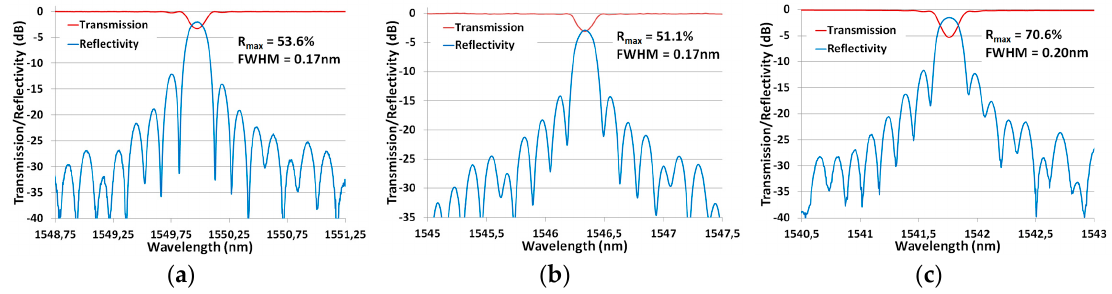
Figure 6. Transmission/reflectivity spectra of FBG written in fiber with: ( a ) High-temperature acrylate coating (Fibercore SM1500(9/125)HT); ( b ) silicone coating (Fibercore SM1500(9/125)S); and ( c ) polyimide coating with pure silica core (Fibercore SM1500SC(9/125)P).